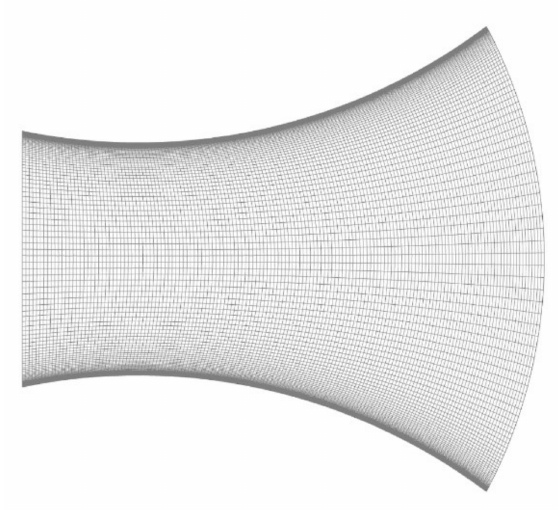
Figure 1. Nozzle numerical mesh.